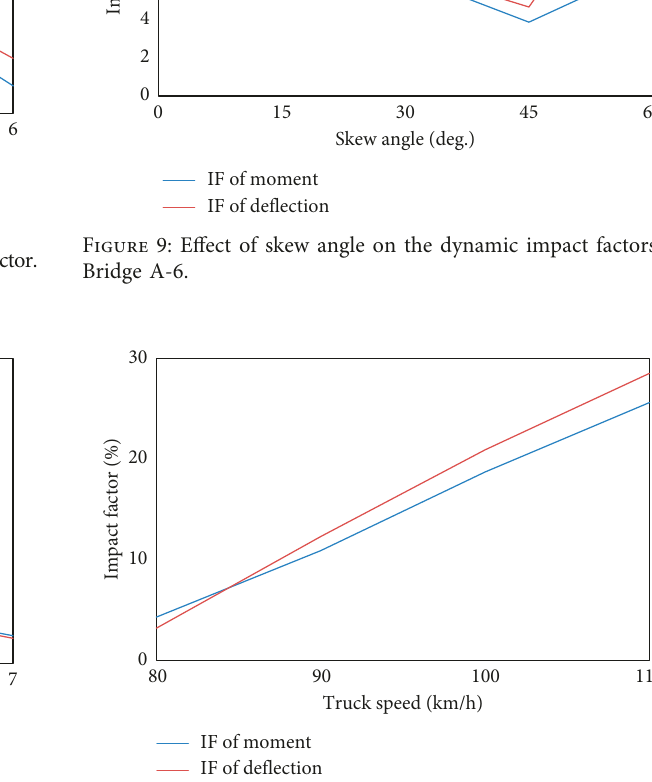
Figure 10: Relationship between truck speed and dynamic impact factor.